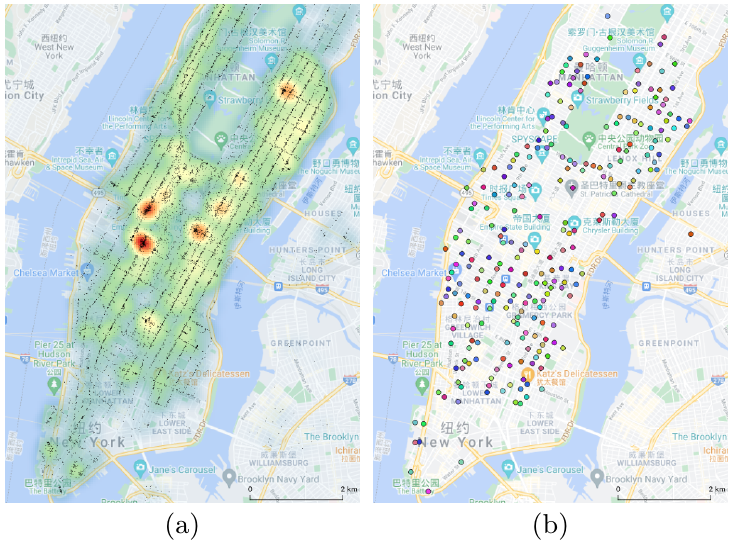
Figure 1. Spatial distribution of one hour’s taxi order data in New York City ( a ) and virtual stations discovered by clustering ( b ). Each dot in ( a ) represents a taxi order origin and the underlying heatmap highlights the hot spots in the city.